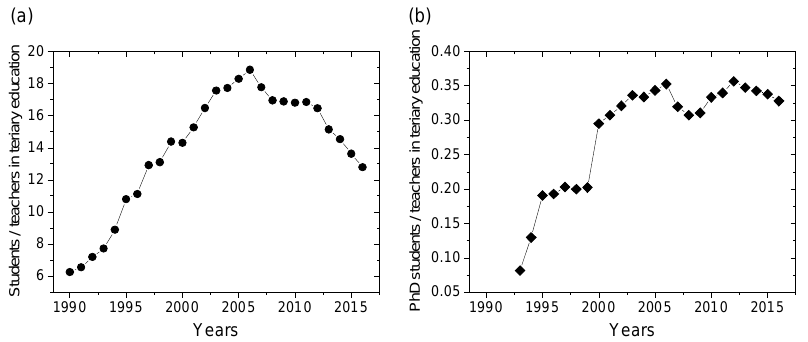
Figure 1. The student/teacher ratio from 1990 to 2016 in Hungary for all students in ( a ) higher education and ( b ) in Ph.D. studies. The number of students and teachers have fallen since 2005, the number of Ph.D. students have remained roughly the same. Data comes from the Central Statistical Office of Hungary (http://www.ksh.hu/docs/hun/xstadat/xstadat_eves/i_zoi007a.html).